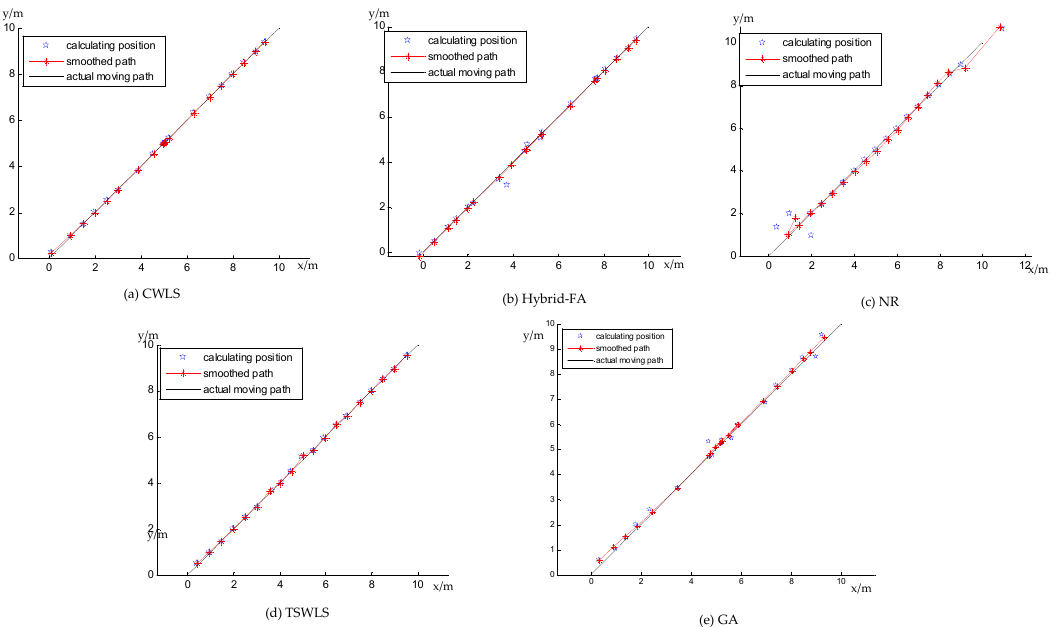
Figure 9. The trajectory tracking of the five methods based on TDoA. ( a ) The trajectory tracking of constrained weighted least squares (CWLS). ( b ) The trajectory tracking of hybrid-FA. ( c ) The trajectory tracking of Newton–Raphson (NR). ( d ) The trajectory tracking of two-step weighted least squares (TSWLS). ( e ) The trajectory tracking of the genetic algorithm (GA).